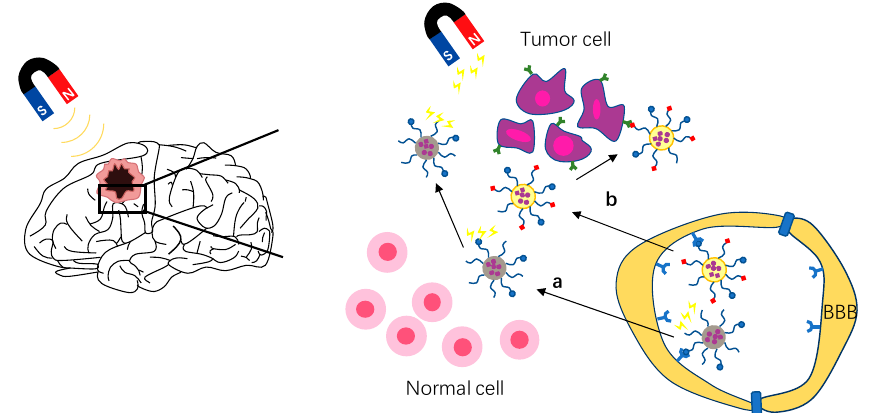
Figure 4. Schematic of strategies to enhance brain tumor targeting. ( a ) Schematic of magnetic targeting brain tumor strategy. ( b ) Schematic of active targeting strategy, shown here as double targeting strategy.